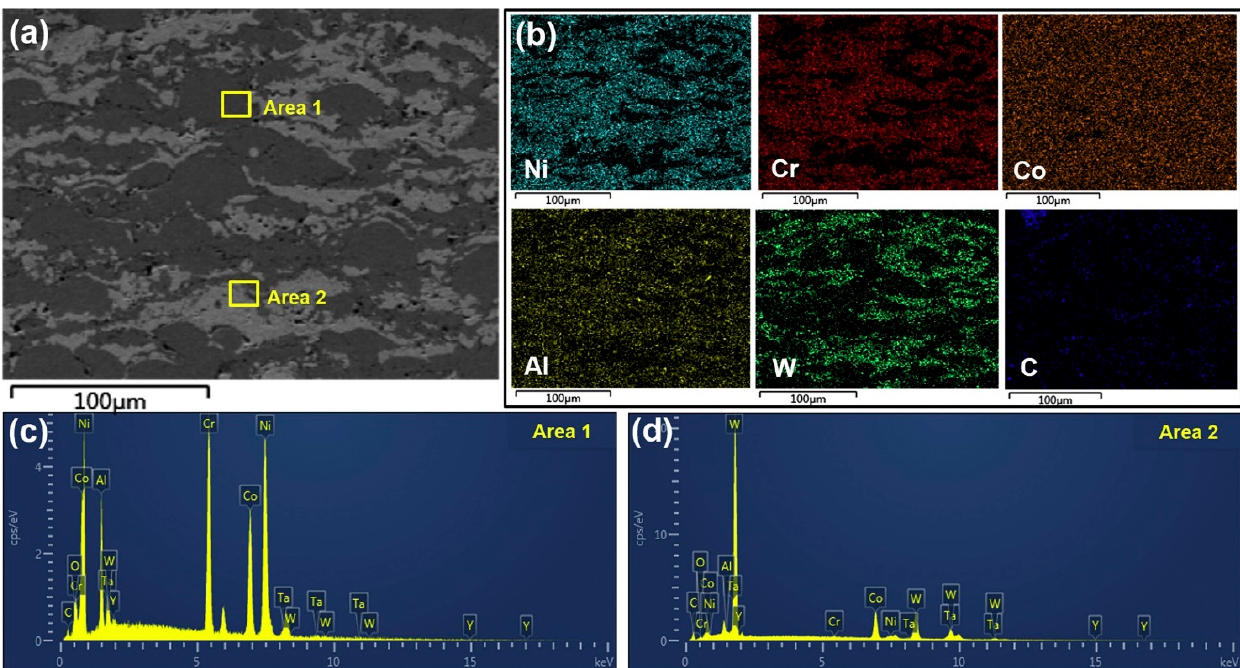
Figure 11. The cross-section of NiCoCrAlYTa-50%WC-Co coating: ( a ) SEM images; ( b ) EDS mapping; ( c , d ) EDS spectrum of the area in image ( a ) (reproduced from [92] with permission from Elsevier).